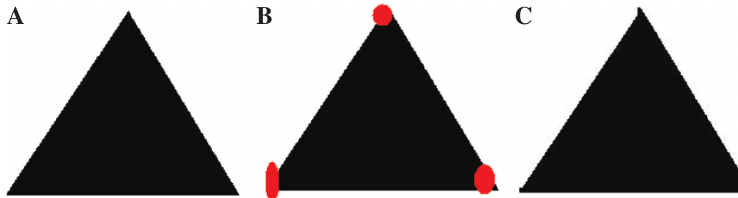
Figure 13. Corner Reconstruction.